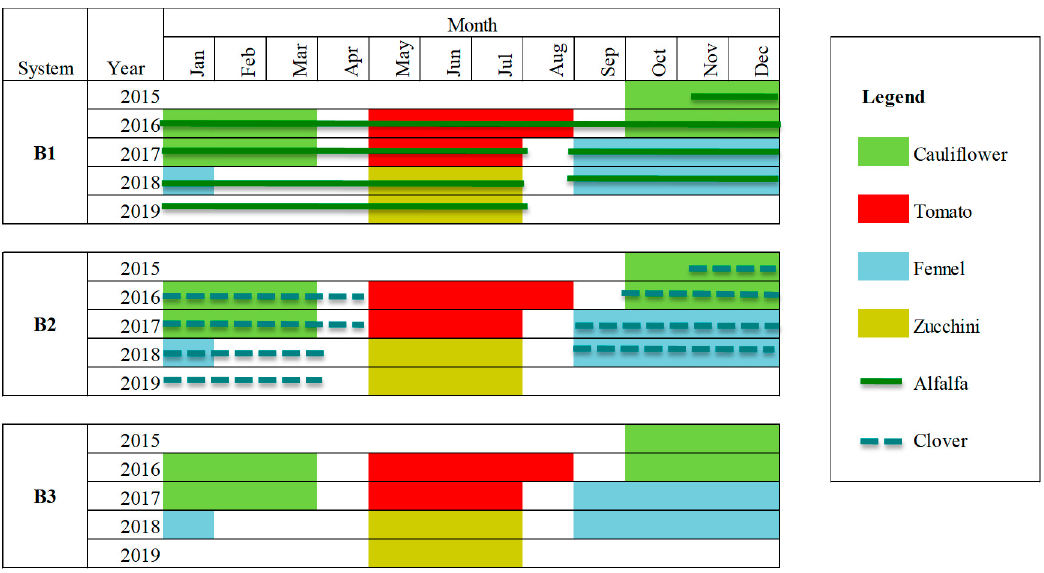
Figure 2. Time sequence of the cash crops and the agroecological service crops (ASC) throughout the four-year experiment divided by three different cropping systems. (B1 = alfalfa as living mulch during both winter and summer periods, flattened with a no-till roller crimper; B2 = clover as living mulch during the winter period, chopped and plowed as green manure; B3 = control without ASC).